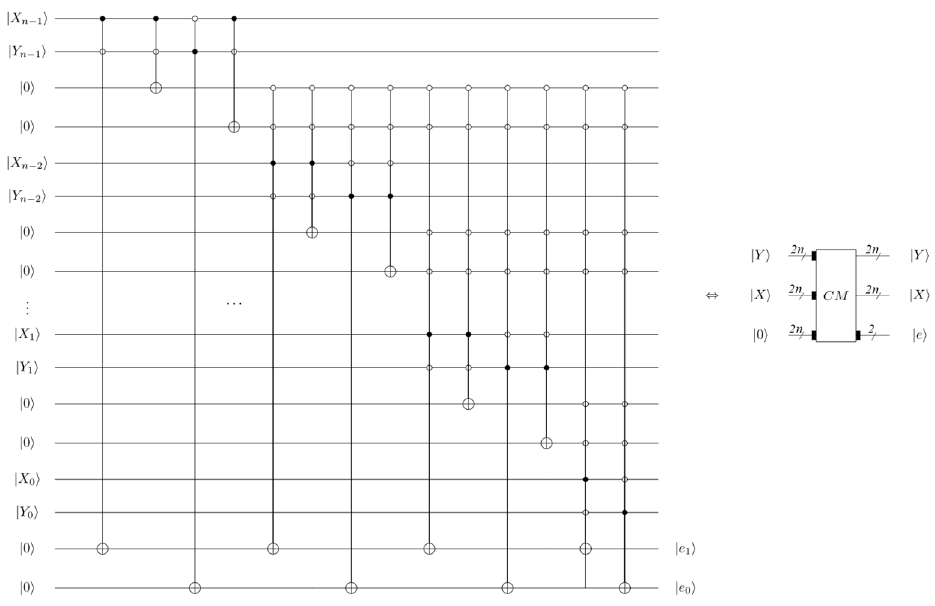
Figure 7. Compare operation circuit.